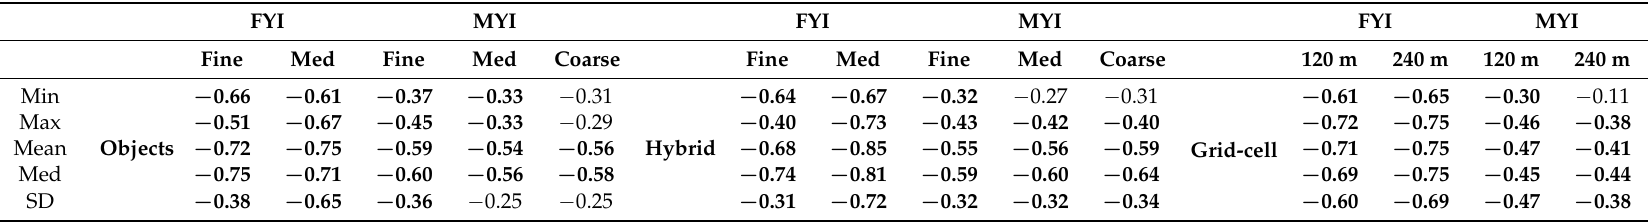
Table 2. Spearman correlation coefficients (r s ) between metrics of winter sea ice thickness and spring f p for FYI and MYI at fine, medium (med) and coarse spatial scales (object and hybrid) as well as 120 and 240 m grid-cells. Bolded values are statistically significant ( p < 0.05).